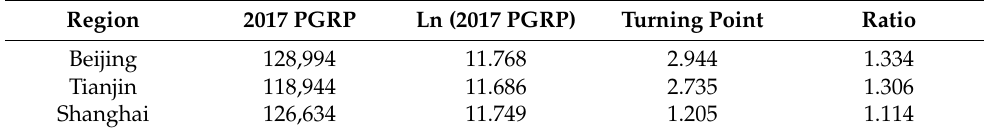
Table 5. Calculated Turning Points of EKC; unit: 100 million CNY. Region 2017 PGRP Ln (2017 PGRP) Turning Point Ratio Beijing 128,994 11.768 2.944 1.334 Tianjin 118,944 11.686